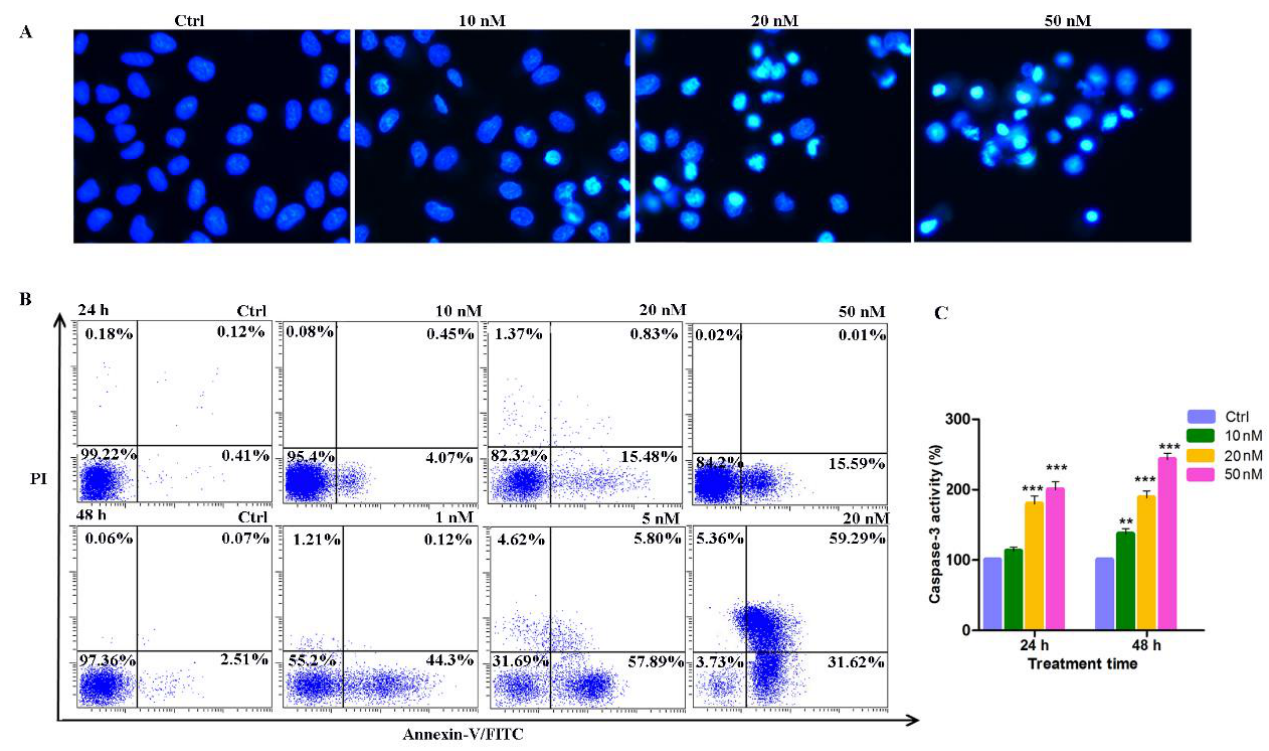
Figure 4. Induction of apoptosis by compound 14b . ( A ) The Hoechst 33342 staining of A549 cells after treatment with compound 14b at the indicated concentrations for 24 h. ( B ) The percentages of cells in each apoptosis quantitated by flow cytometry through Annexin V-FITC double staining analysis. Upper left quadrant (Annexin V − /PI + ): necrotic cells; upper right quadrant (Annexin V + /PI + ): late apoptotic cells; bottom left quadrant (Annexin V − /PI − ): live cells; bottom right quadrant (Annexin V + /PI − ): early apoptotic cells. ( C ) The caspase 3 activity detected by the caspase 3 colorimetric assay kit after A549 cells were treated with compound 14b at concentrations of 10, 20 and 50 nM for 24 h. The experiments were performed at least three times, and the results of the representative experiments are shown. Data are presented as mean ± SEM. ** p < 0.01, *** p < 0.001 vs. control group; significant difference as compared with the control group by t test.